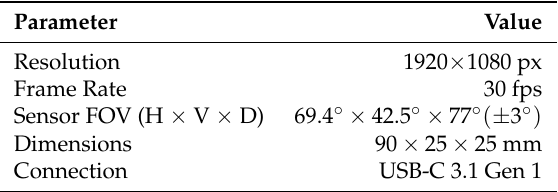
Table 2. Specifications of Intel RealSense D435i camera